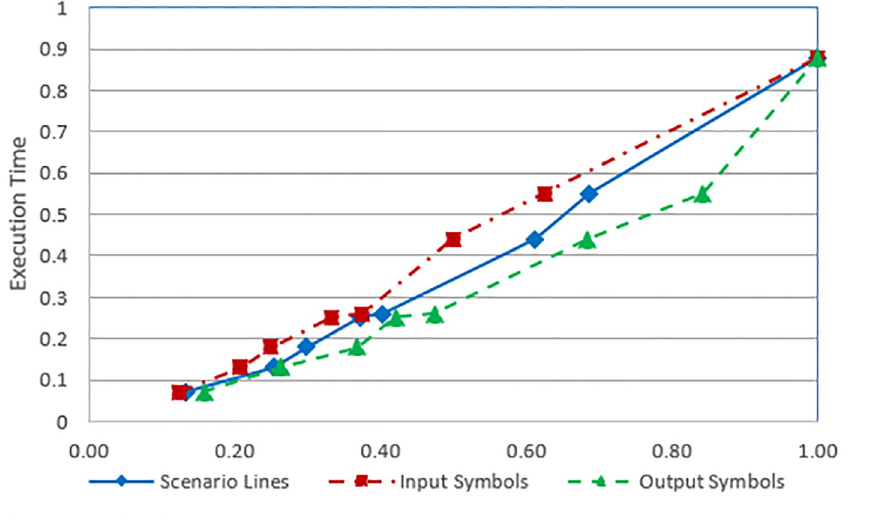
Fig 13. Execution time to use case